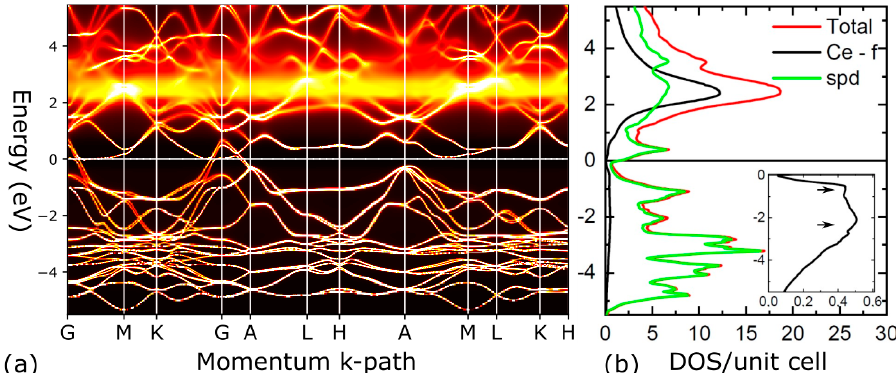
Figure 6. Electronic structure calculations for CePdSb: DFT calculations for a structure with no puck- ering, panel ( a ) versus a structure with puckering, panels ( b – d ) show the spectral functions obtained from the DFT+eDMFT calculations, for the same structures used in panels ( a , b ); the black and yellow arrows point to the most significant changes occurring in the electronic structures versus puckering; in all calculations, we used the experimental crystal structures.